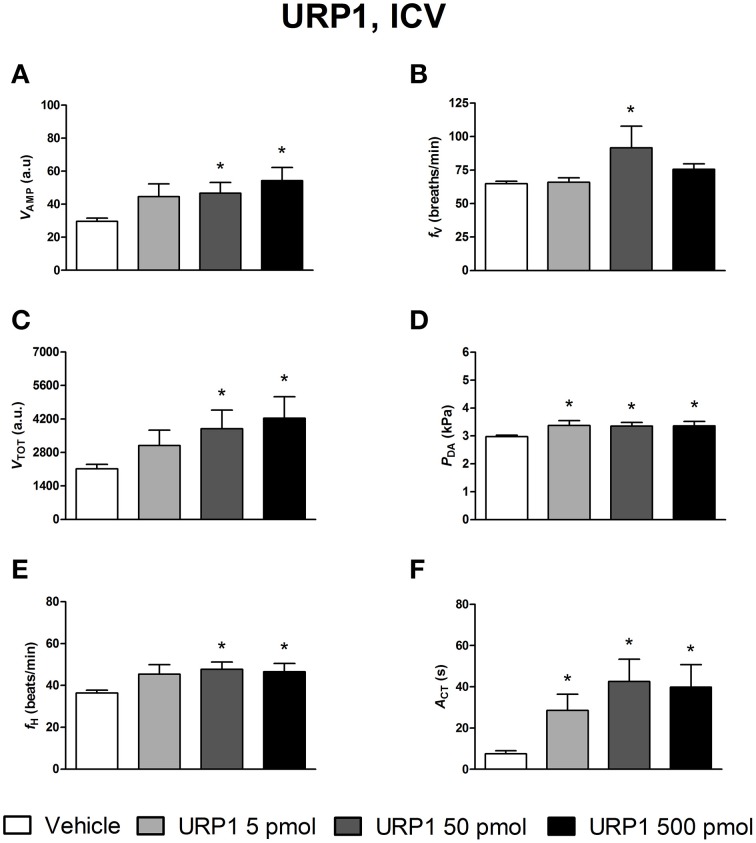
Histograms showing the maximal effects of ICV injection of 0.5 μl vehicle (n = 31), 5 pmol URP1 (n = 11), 50 pmol URP1 (n = 12) and 500 pmol URP1 (n = 10) on ventilatory amplitude (VAMP, A), ventilatory frequency (fV, B), total ventilation (VTOT, C), dorsal aortic blood pressure (PDA, D), heart rate (fH, E), and motor activity (ACT, F). *P < 0.05 vs. vehicle injection.